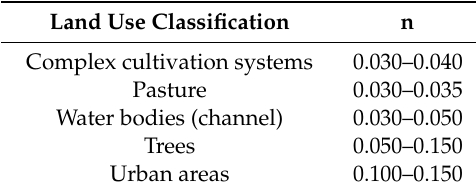
Figure 9. Overview of the land cover of the study area (source USGS website) [27]. Table 1. Manning’s n values for each land use type [28].